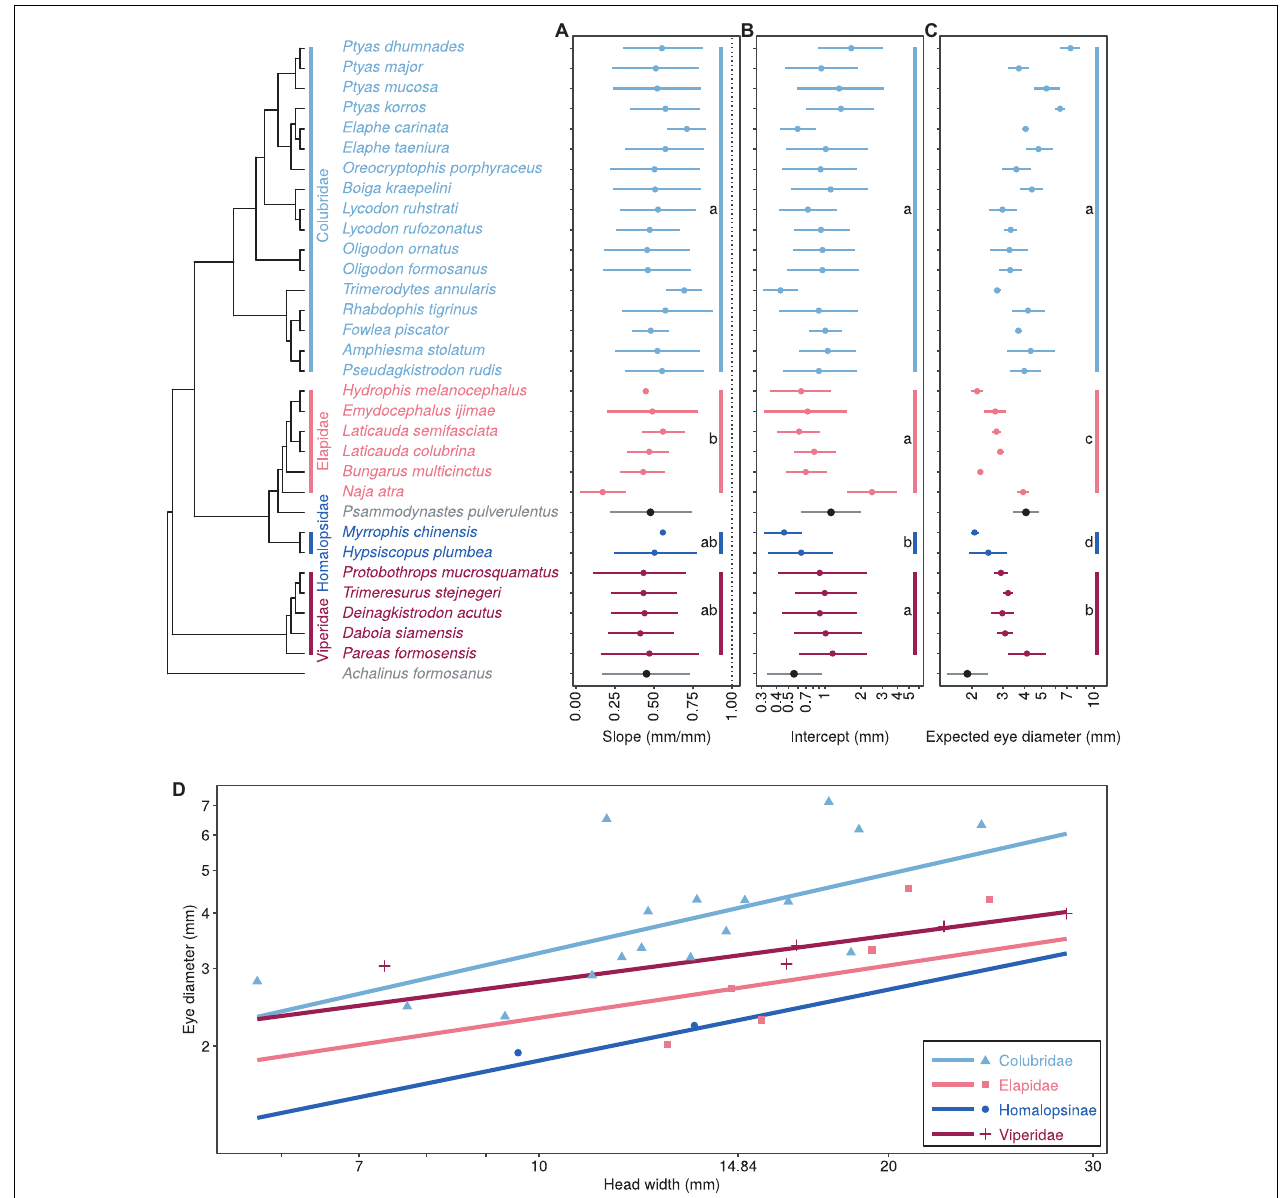
FIGURE 1 | Comparison of growth patterns of eye diameter and head width for different taxa, including allometric growth index (A) , proportionality coefficient (B) , expected eye diameter (C) and scatter diagram (D) . Different color dots and lines are used to represent the four major taxa. In subplots (A–C) , the dots and horizontal lines represent the median and 95% HDI of the posterior distribution, respectively, and lowercase letters indicate multiple comparisons between groups (no identical letters indicate significant differences). In (D) , the points indicate the mean head width and eye diameter within each